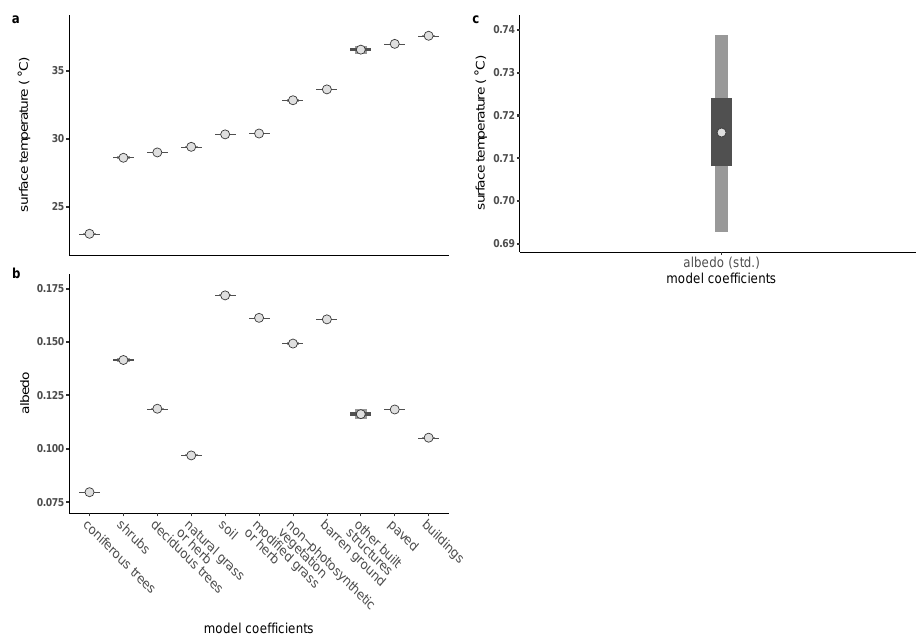
Figure 3. Main model results showing 95% credible intervals (outer) and 50% credible intervals (inner) of the effects of land cover classes (and their interactions with albedo) on surface temperature. See Table A1 for model coefficients. See Figure 4 for additional model results.